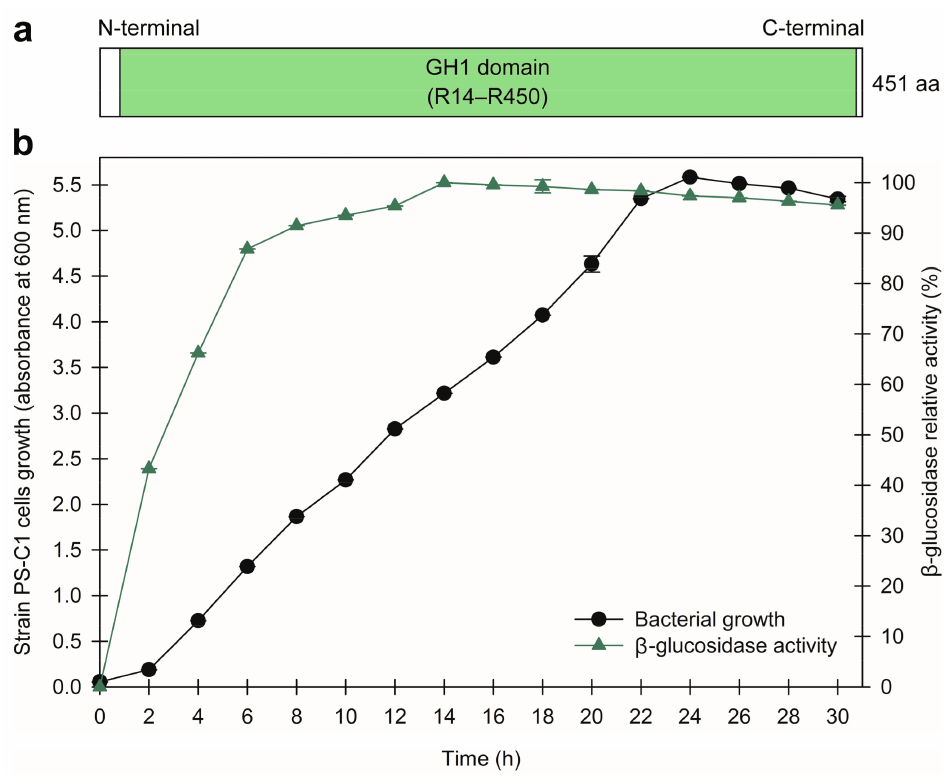
Figure 4. ( a ) Schematic representation of domain organisation for β -glucosidase in strain PS-C1 (BglPS-C1); aa: amino acids. ( b ) Time courses of growth of strain PS-C1 and BglPS-C1 production by cultivation in the marine broth supplemented with 1.0% ( w / v ) cellobiose. p -Nitrophenyl- β -D- glucopyranoside ( p NPG) was used as the enzymatic substrate. The values shown represent the mean ± standard error of triplicate